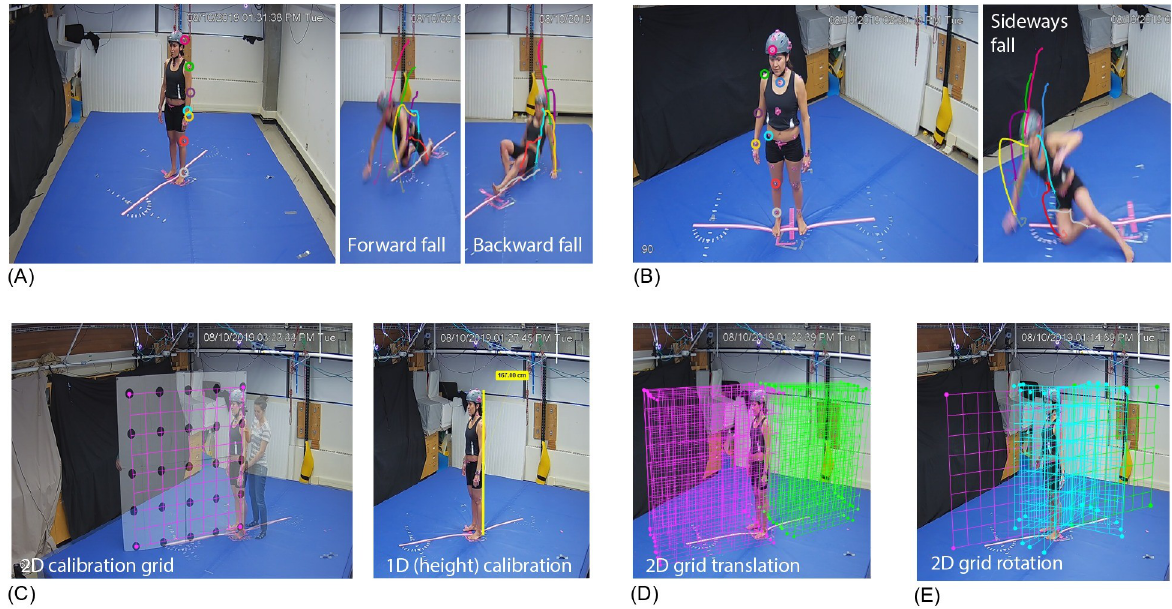
Fig 1. Experimental setup. Experimental setup for (A) forward and backward and (B) sideways falls illustrating Kinovea traces from digitization of key anatomical locations. Right panels display digitized traces from Kinovea of the time-varying positions during the falls of the head (pink), shoulder (green), elbow (purple), wrist (yellow), hip (light blue), knee (red), ankle (grey) and sternum (dark blue). Pink tape of the mat displays the plane of the fall. We examined how the accuracy of kinematic outcomes from Kinovea depended on (C) calibration technique (2D calibration grid versus 1D calibration based on participant height), (D) calibration frame translation (purple grids for forward falls and green grids for backward falls), (E) calibration grid rotation (blue grids), and camera view with respect to the fall (30, 60 and 90 degree views shown in (A), (C), and (B),